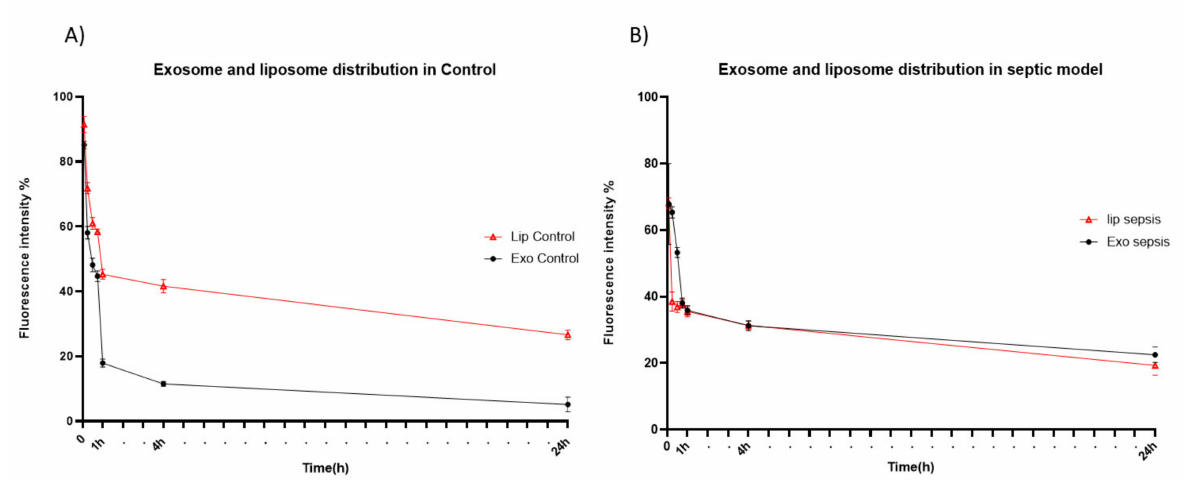
Figure 4. Blood circulation of HEK293T cell-derived exosomes and PEGylated liposomes after intravenous injection. ( A , B ) Fluorescent signal intensity of blood sample obtained from healthy ( A ) and sepsis mice ( B ) at different time points after intravenous injection of exosomes (closed circle) and liposomes (open triangle). The results represent mean ± SD ( n =